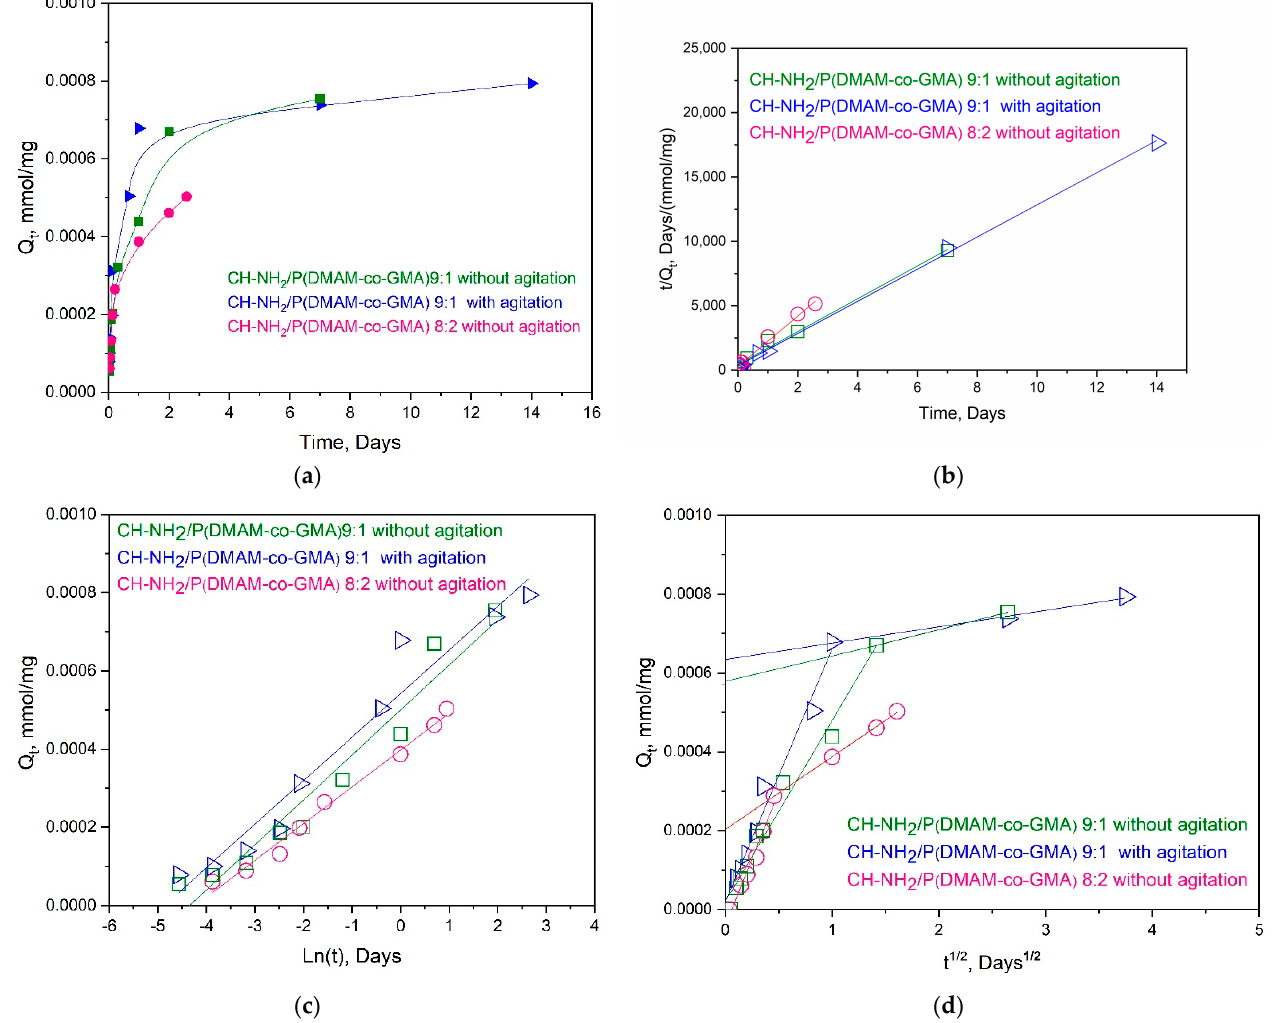
Figure 9. ( a ) Effect of contact time on adsorption capacity of the membranes Ch-NH 2 /P(DMAM-co- GMA) 9:1 and 8:2 in aqueous 1 mM CuSO 4 solution, with or without magnetic stirring. Fitting of the experimental data with the ( b ) pseudo-second order, ( c ) Elovich and ( d ) Weber–Morris intraparticle diffusion model.